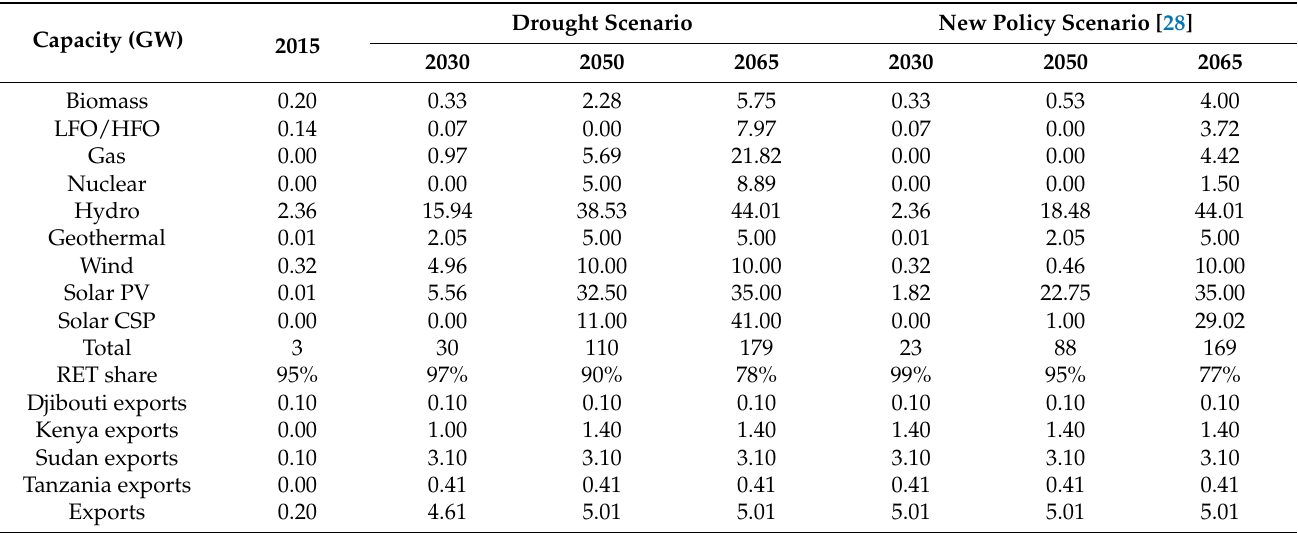
Table 2. Comparison of Power Generation Capacity of Drought and New Policy Scenario.